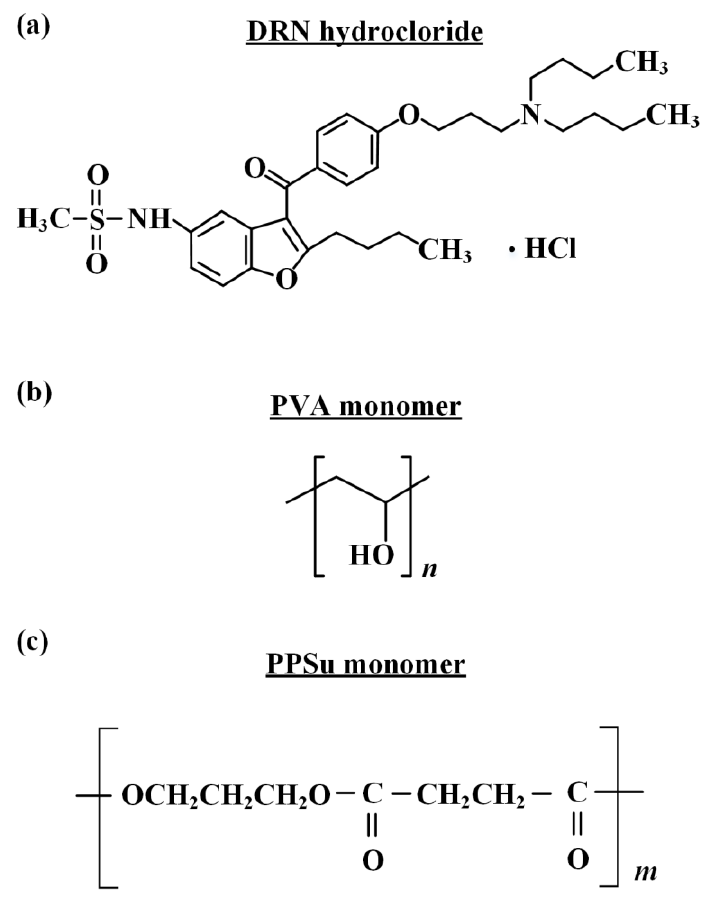
Figure 1. Chemical structures of ( a ) DRN (HCl salt), ( b ) PVA monomer and ( c ) PPSu